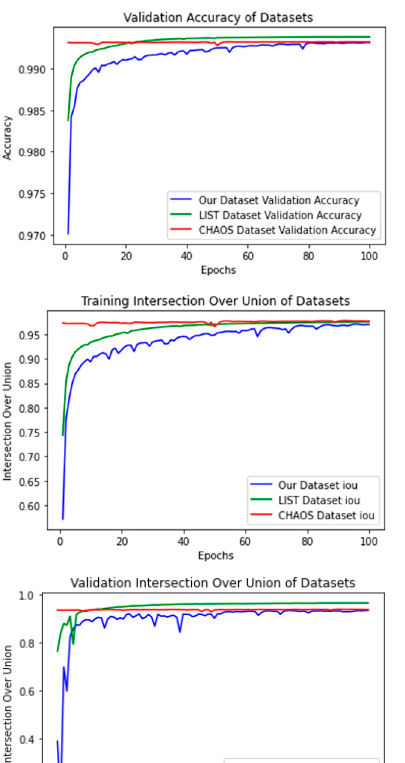
Table 3. Measurement performances of AIM-Unet on test datasets.